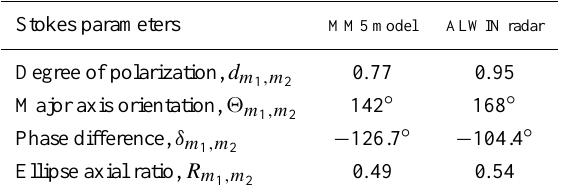
Table 1. Stokes parameters derived from MM5 model output and radar measurements for the altitude range from 3–9km at Andenes on 25 January 2003 after band pass-filtering with bandwidths of 8– 18h in time and 2–8km in height. Stokes parameters MM5 model ALWIN radar Degree of polarization, d m 0 . 77 0 . 95 1 ,m 2 Major axis orientation, 2 m 142 ◦ 168 ◦ 1 ,m 2 − 126.7 ◦ − 104.4 ◦ Phase difference, δ m 1 ,m 2 Ellipse axial ratio, R m 0 . 49 0 . 1 ,m 2